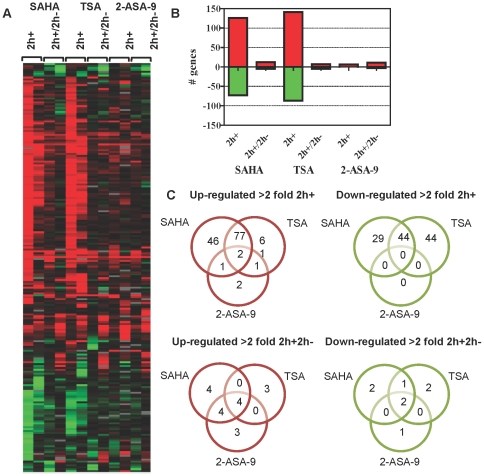
Global transcriptional response of P. falciparum to hydroxamate-based HDAC inhibitors.Synchronous 3D7 trophozoite-stage parasites were treated with DMSO (0.05%) or IC90 amounts of SAHA, TSA, or 2-ASA-9. RNA was collected from parasites after treatment for 2 h (2 h+), or after 2 h, washing, and culture for a further 2 h (2 h+/2 h−). cDNA was synthesized from RNA and labelled with Cy5 and hybridized against Cy3 labelled 3D7 reference pool. Microarray data, including mRNA abundance ratios between each sample and the 3D7 reference pool, was filtered as described in material and methods. Data shown are genes with >2 fold differential expression induced by the compounds. Heat map showing up- (red), down- (green) regulated or relatively unchanged (black) genes, for two independent biological replicates for each compound (A). The total number of genes with altered expression is shown graphically (B) and genes commonly or uniquely regulated in 2 h+ or 2 h+2 h− parasites are shown in Venn diagrams (C). For (B) and (C) data are the combined replicates for each compound to show genes commonly up- or down-regulated for each compound and treatment time. For example, 127 genes were up-regulated in common between both biological replicates for parasites treated with SAHA for 2 h (B).